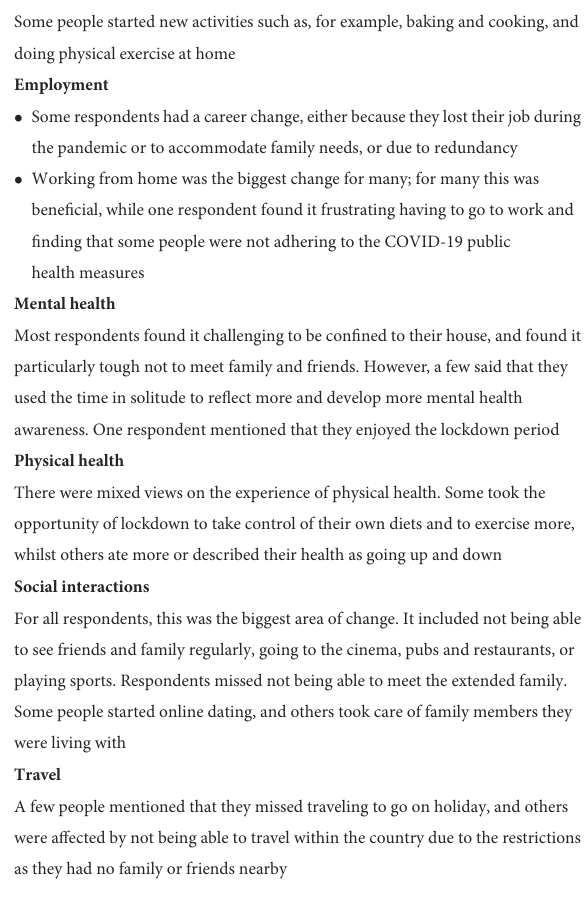
TABLE 7 Main areas of change according to